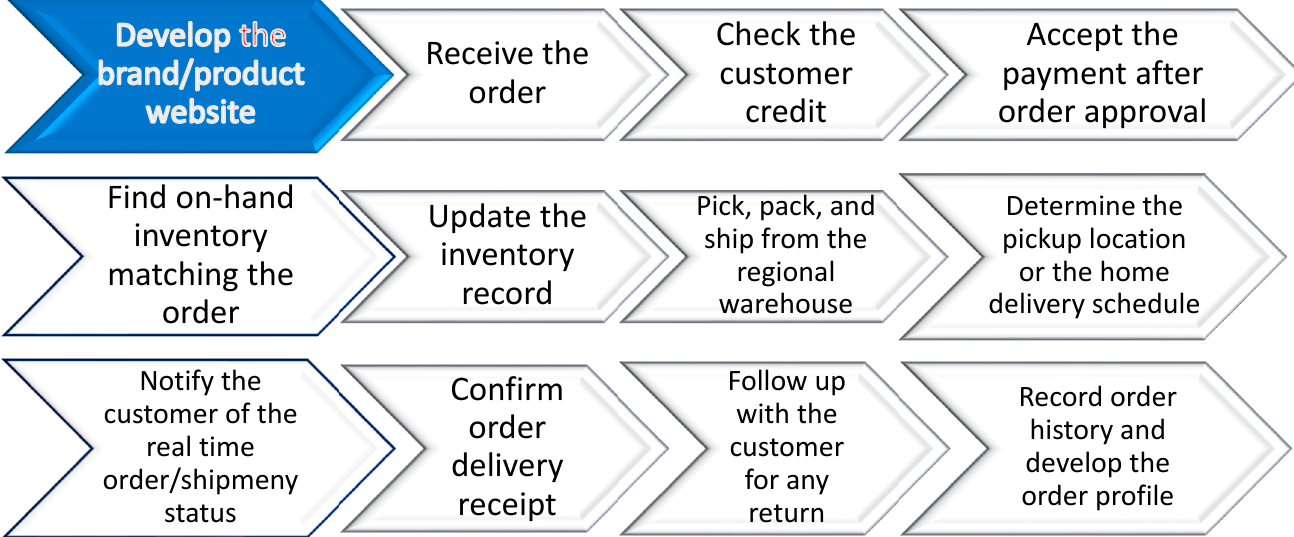
Figure 3. The Omni-channel Order Fulfillment Process.